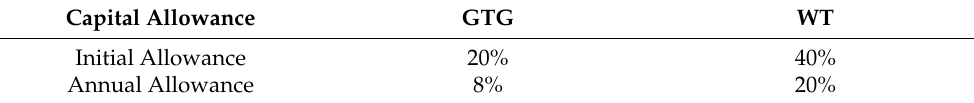
Table 4. Capital allowance.